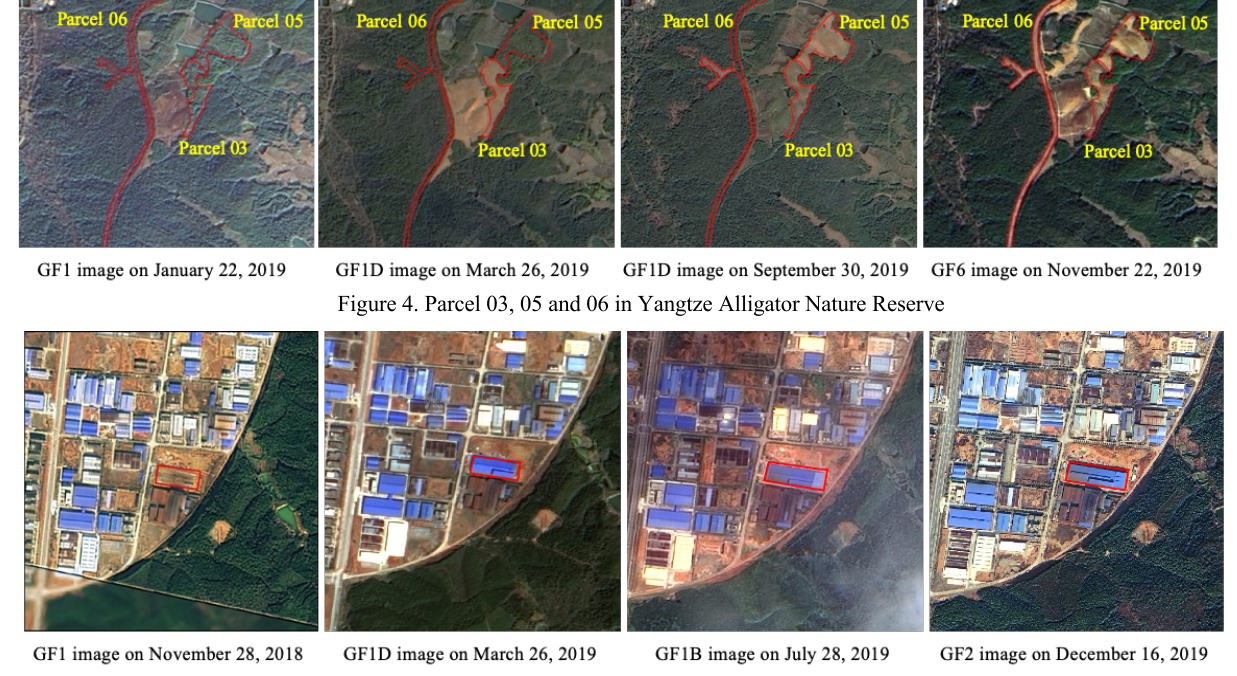
Figure 5. Parcel 04 in Yangtze Alligator Nature